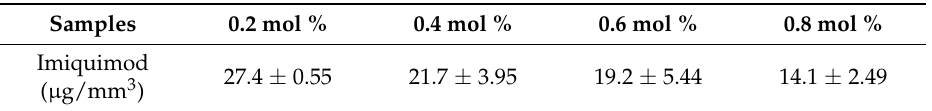
Table 1. The loaded amount of imiquimod corresponding to the poly(MEO 2 MA) hydrogel samples with four different molar feed ratios of cross-linker.